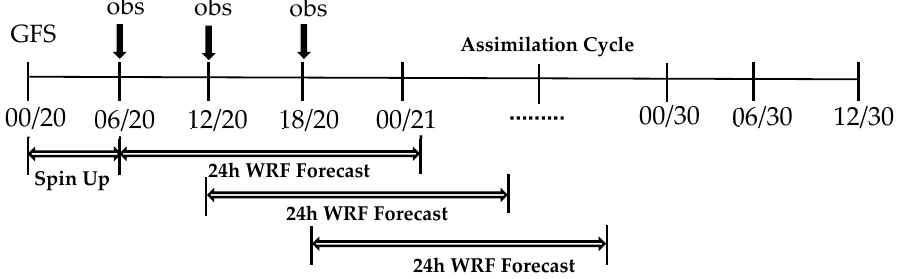
Figure 3. A flow chart of the cycling data assimilation experiment.